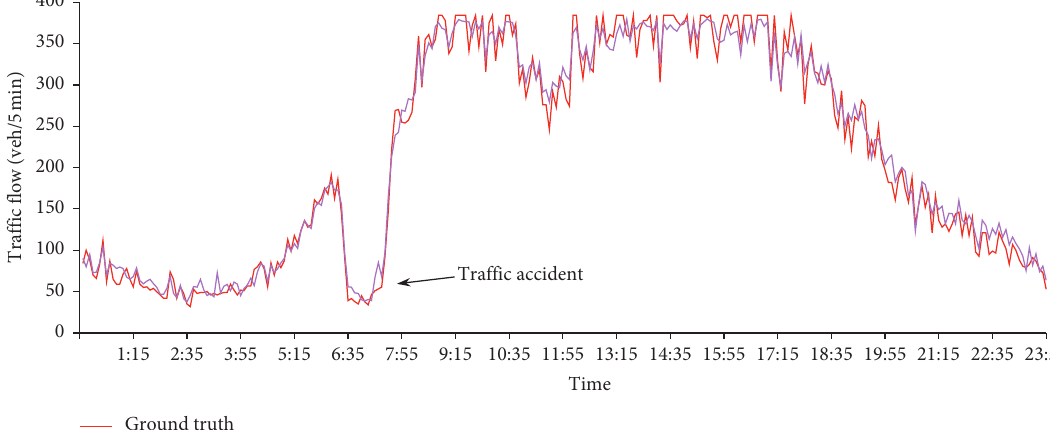
Figure 11: Special sample (traffic accident) traffic flow prediction results of the XGBoost-I-lag